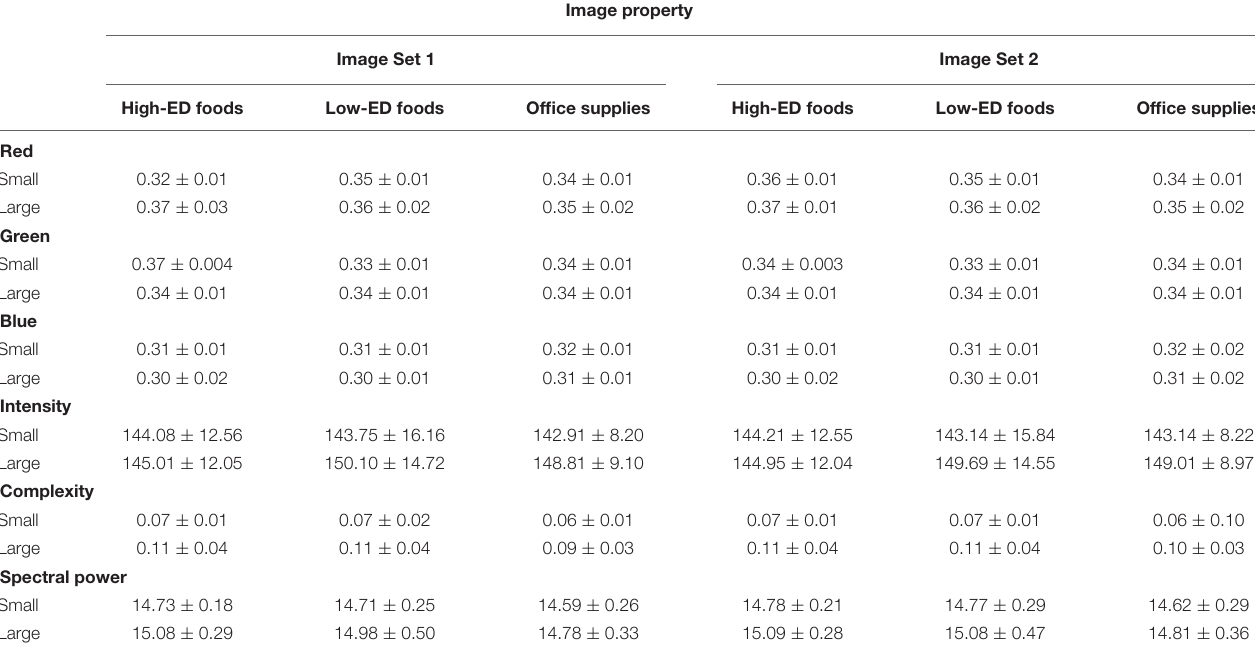
TABLE 3 | Mean image properties assessed in Matlab for food and non-food images grouped by energy density, version, and